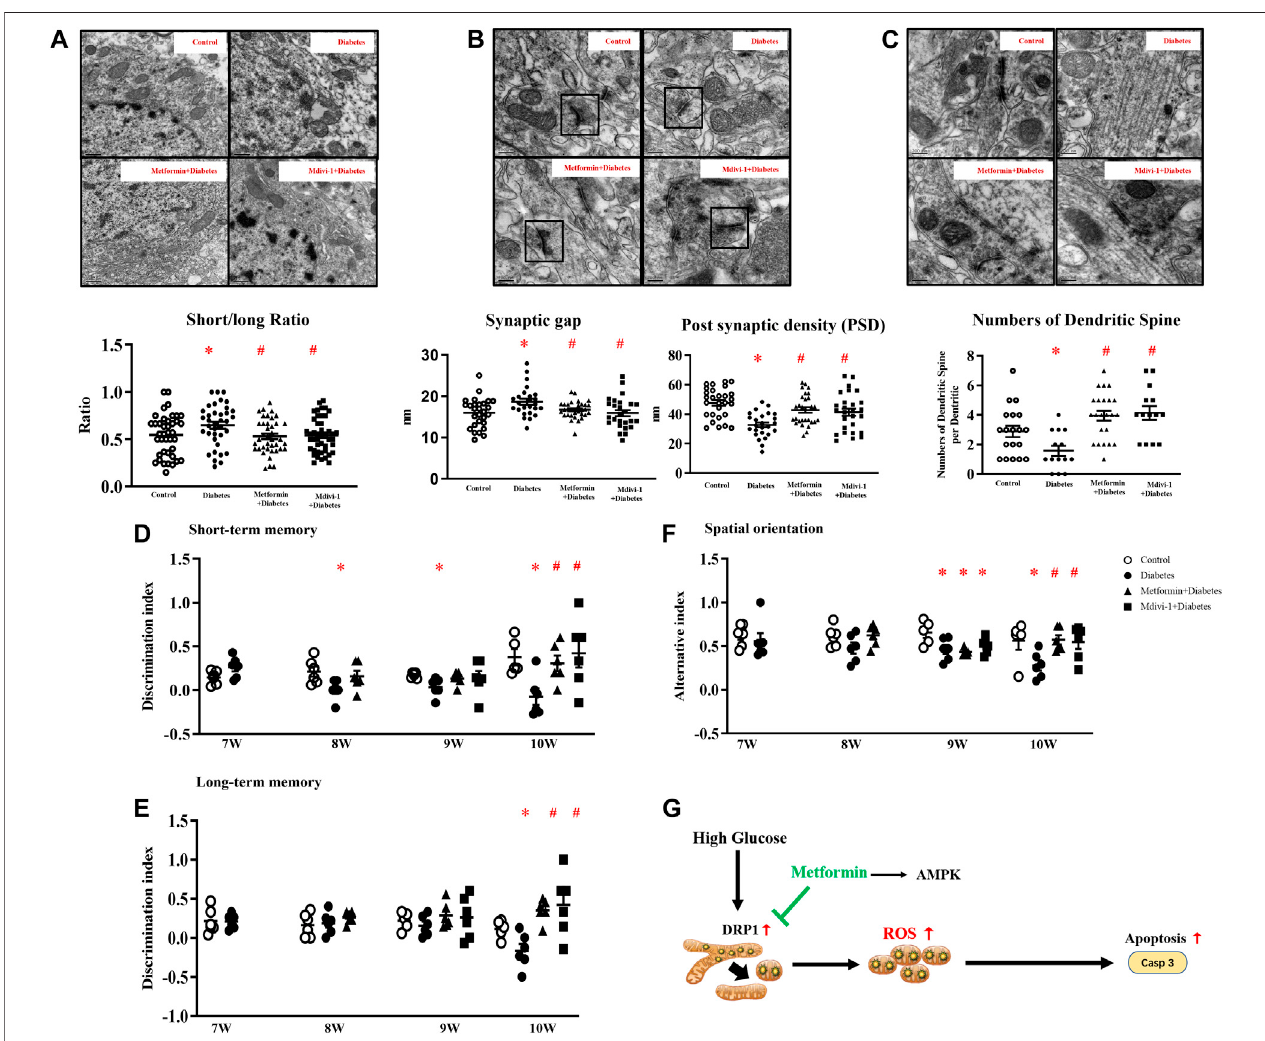
FIGURE 7 | (A) Representative picture of mitochondria in hippocampal neurons (upper) and measurement of mitochondria short/long axis ratio (lower) (39 mitochondria from metformin treatment, 45 from Mdivi-1 treatment, n = 3, 200,00×, Bar = 0.5 µm) (B) Representative picture of a synaptic gap in the hippocampus (upper) and measurements of synaptic gap and PSD (lower) (30 synapses from metformin treatment, 26 from Mdivi-1 treatment, n = 3, 500,00×, Bar = 200 nm). (C) Representative picture of dendritic spines in the hippocampus (upper) and counts of dendritic spines per dendrite (lower) (23 dendrites from metformin treatment, 14 from Mdivi-1 treatment, n = 3, 500,00×, Bar = 200 nm). Metformin and Mdivi-1 protect against diabetes-induced cognitive dysfunction in short-term memory (D) , long-term memory (E) , and spatial disorientation (F) . Data presented as means ± SEM, * p < 0.05 vs m/m control, # p < 0.05 vs db -/- control by One-way ANOVA (G) Schematic diagram. High glucose increases mitochondrial fragments by activating DRP1 protein, resulting in elevated oxidative stress and cell apoptosis. Metformin inhibits DRP1 phosphorylation, reduces mitochondrial-derived oxidative stress, and prevents neuron loss.